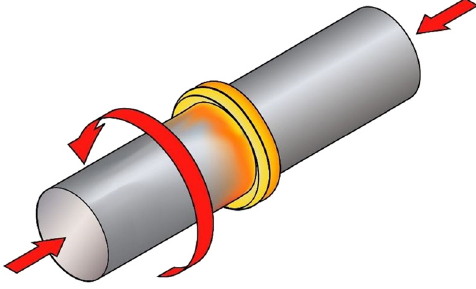
Figure 1: Schematic representation of RFW.